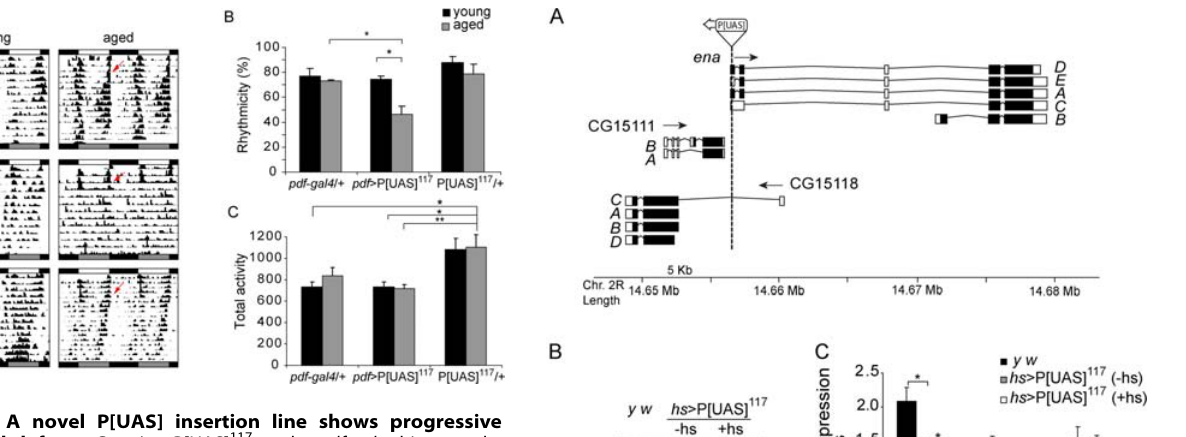
Figure 2. A novel P[UAS] insertion line shows progressive behavioral defects. Crossing P[UAS] 117 to the pdf-gal4 driver results in a significant decrease in the rhythmicity of old flies. (A) Representative double plotted actograms for young (3d) and aged (21d) flies of pdf-gal4/ P[UAS] 117 along with the corresponding controls. (B) The percentage of rhythmic flies for each strain is shown. Older pdf- gal4/ P[UAS] 117 flies are significantly different from their younger counterparts and from the aged controls (* p , 0.05). Experiments were repeated at least three times. Additional details are included in Table S2. (C) No progressive decrease in daily activity was observed in either line. Although no differences were found between pdf-gal4/ P[UAS] 117 and pdf-gal4/ + individuals, young and aged heterozygous P[UAS] 117 flies were overall more active (* p , 0.05; ** p , 0.01). doi:10.1371/journal.pone.0003332.g002 CG15111 and CG15118. The insertion per se reduced ena levels to about 50 percent of wild type controls ( y w ). Interestingly, heat- shocked flies showed about one third of ena levels compared to is triggering the decrease of endogenous ena levels.